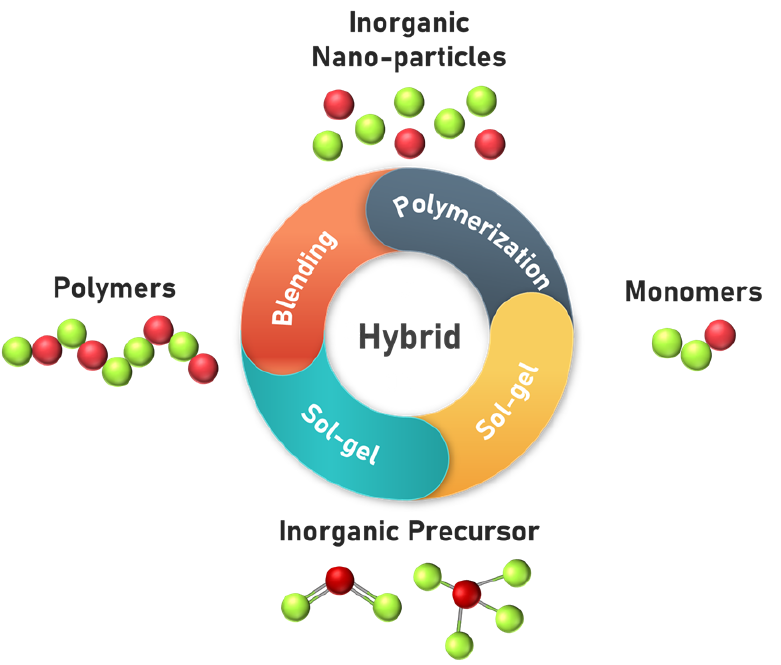
Figure 14. Schematic representation of the different preparation routes for organic – inorganic hybrid materials and AEMs. Table 10. Ionic conductivity of organic – inorganic-based membranes.